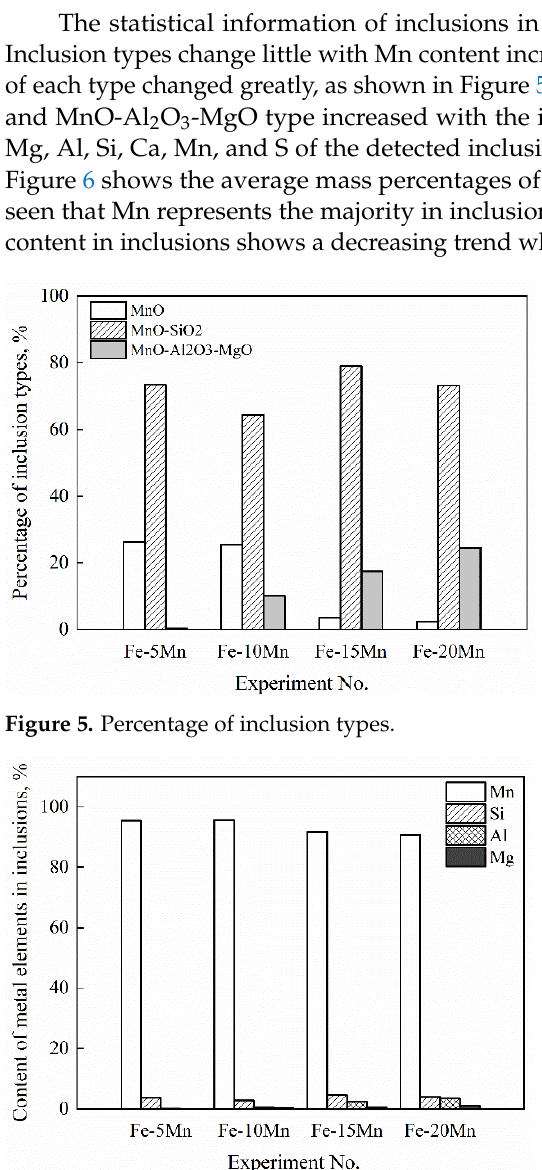
Figure 6. Average contents of main elements in the detected inclusions.